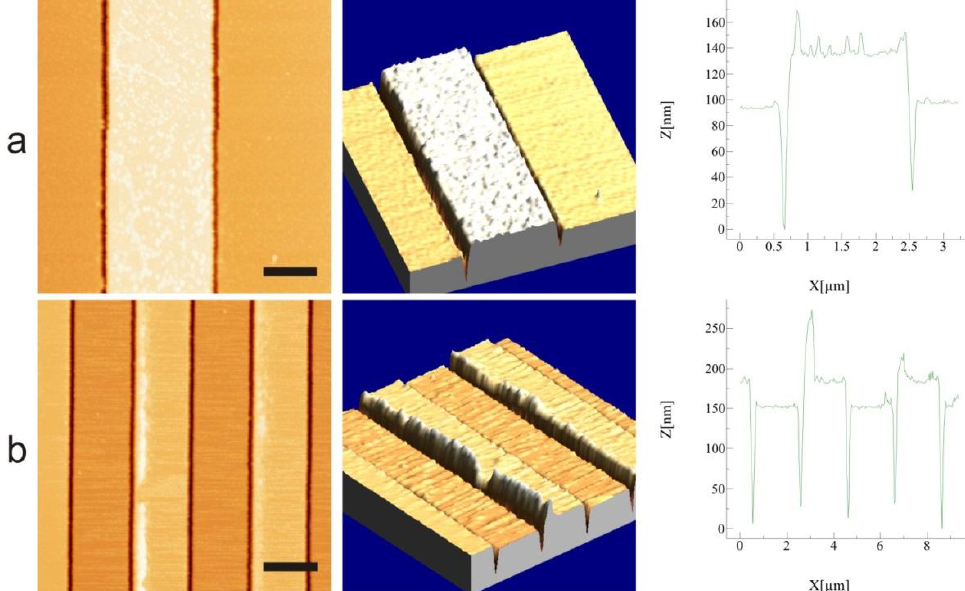
Figure 5. AFM images of 2 µm wide electrodes using the HF etching technique prior to metallization. ( a ) An electrode where no ears are present; and ( b ) an electrode with existing ears with a height that is considerably lower than before and with only partial coverage of the electrode surface. The left panels show the AFM image, the middle panels show a 3D reconstruction of the AFM image and the right panels show a line profile across the electrode width. Scale bar is (a) 1 µm and (b) 2